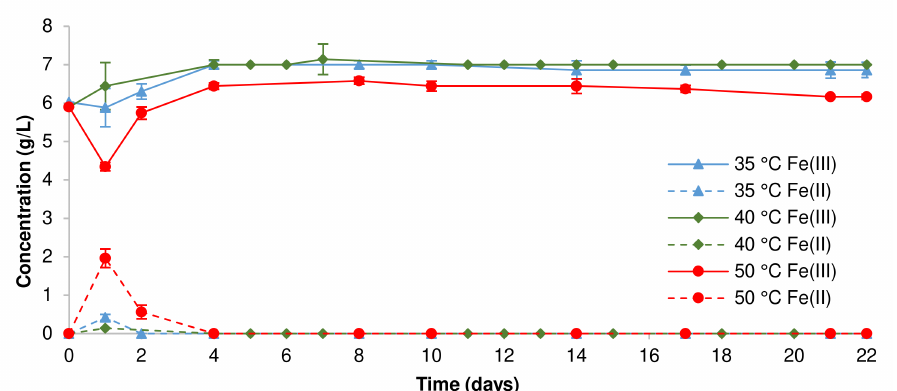
Figure 2. Ferric and ferrous iron concentration in the aqueous phase during stirred-tank bioleaching of the concentrate (pulp density, 1 wt%).